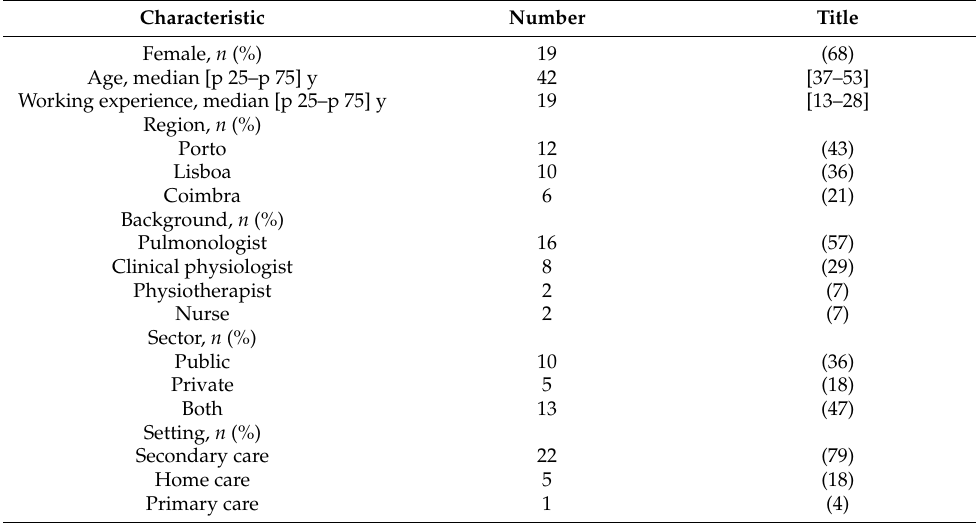
Table 1. Characteristics of healthcare professionals ( n =